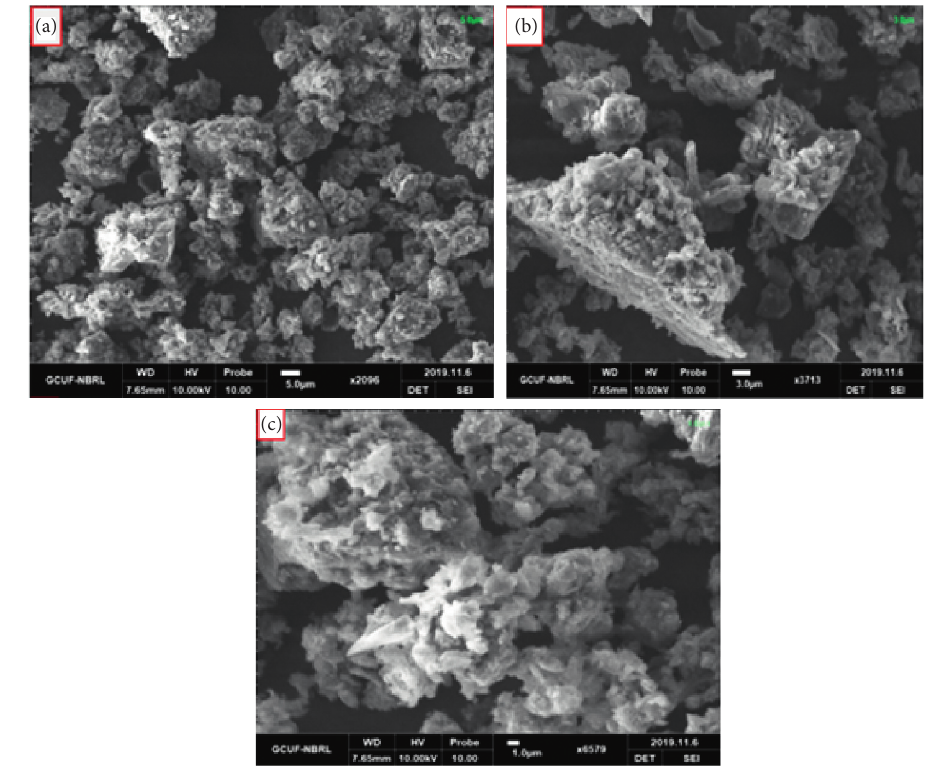
Figure 6: SEM pattern of (Ba � 0.02 to 0.08 and y � 0.2 to 0.8 for hexaferrites. 1 − x La x Mn y Fe 12 − y O 19 ) x